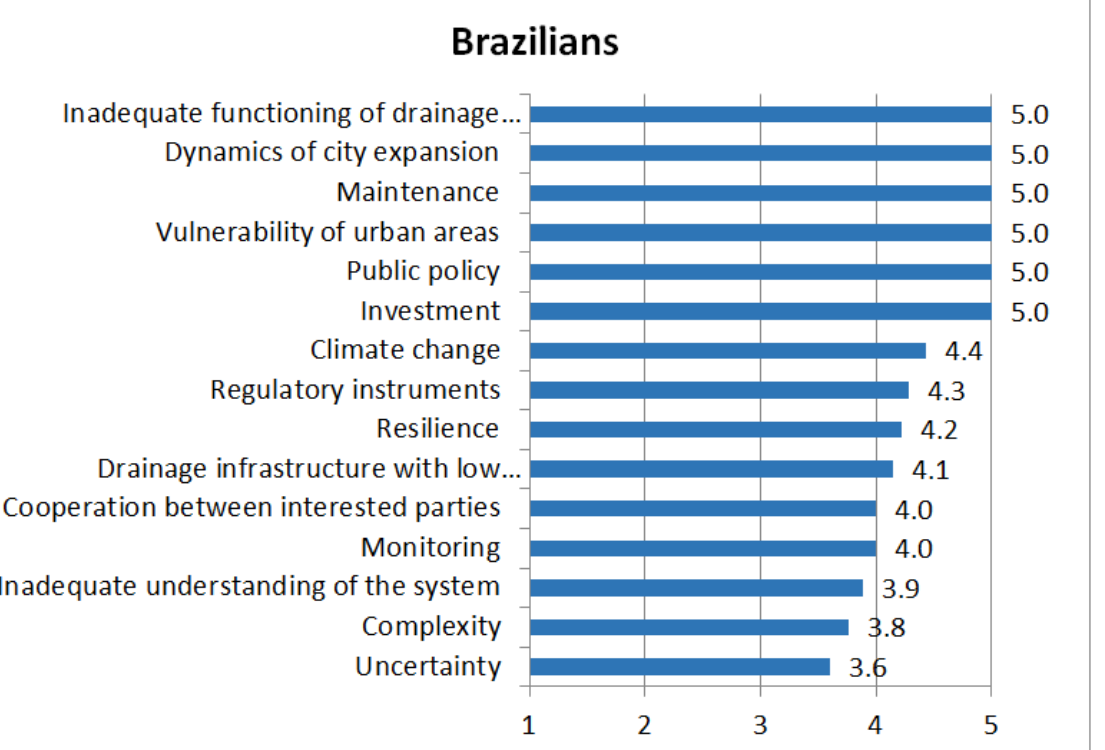
Figure 2. Challenges ranked by relative median .